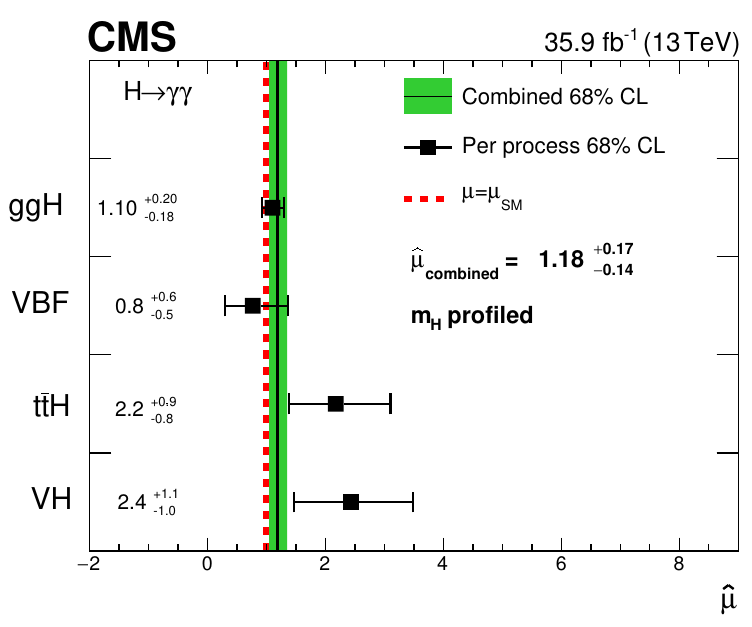
Figure 17 . Signal strength modi(cid:12)ers measured for each process (black points), with the SM Higgs boson mass pro(cid:12)led, compared to the overall signal strength modi(cid:12)er (green band) and to the SM expectation (dashed red